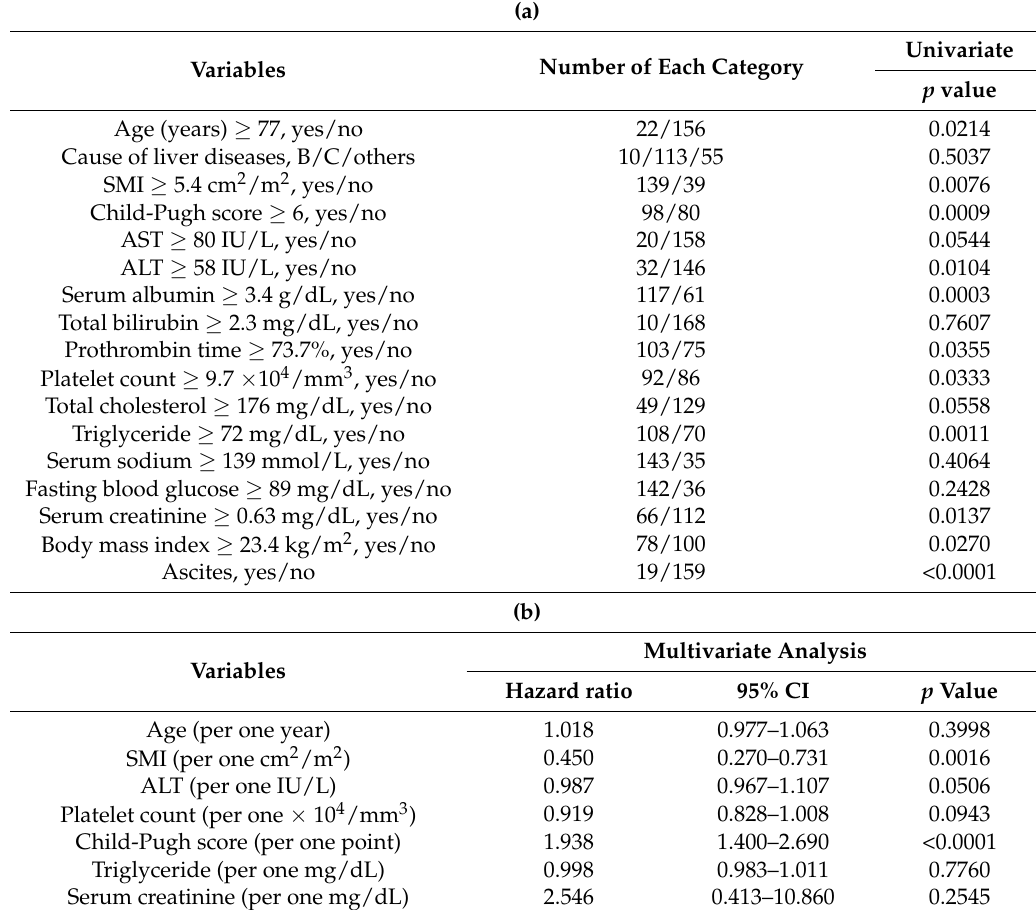
Table 3. ( a ) Univariate analyses of factors linked to overall survival for female ( n = 178). ( b ) Multivariate analyses of factors linked to overall survival for